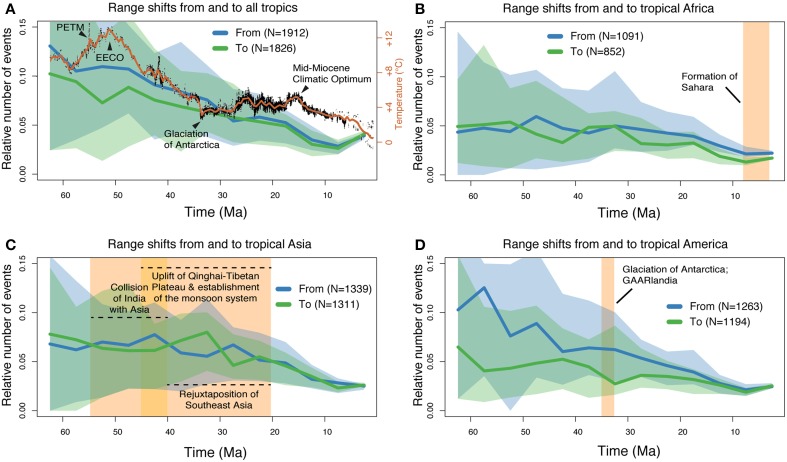
Results from the range shift analyses using stochastic mapping. The plots show the number of range shift events (including long-distance dispersals and continuous range expansions) through time, relative to the available number of lineages (see Methods for details). (A) Inferred number of range shift events into and out of the tropical zone; (B–D) rate estimations for tropical Africa, Asia, and America, respectively. The 95% confidence intervals are shown as shaded areas in all plots. In (A), a global mean temperature curve (Hansen et al., 2008) is shown in red for comparison. The yellow boxes in the other figures are shown as references for the discussion. EECO, Early Eocene Climatic Optimum; PETM, Paleocene-Eocene Thermal Maximum; GAARlandia, Greater Antilles and Aves Ridge landbridge.